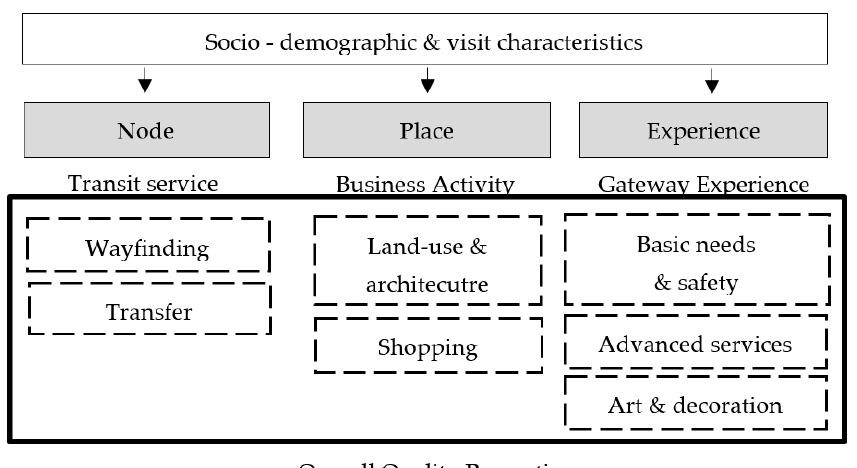
Figure 3. Revised conceptual model.